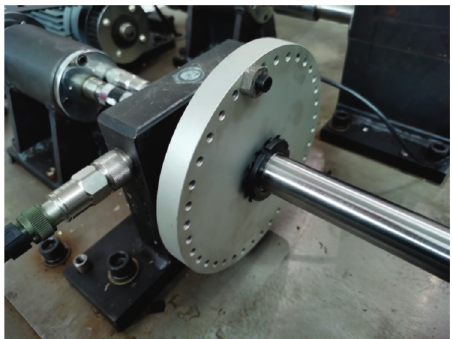
Figure 10: Mandrel screws to move the base.